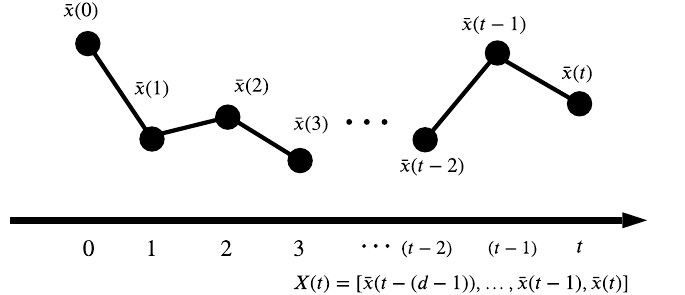
Figure 5. The sliding-window embedding extracted of the time series, which serves as the input to neural